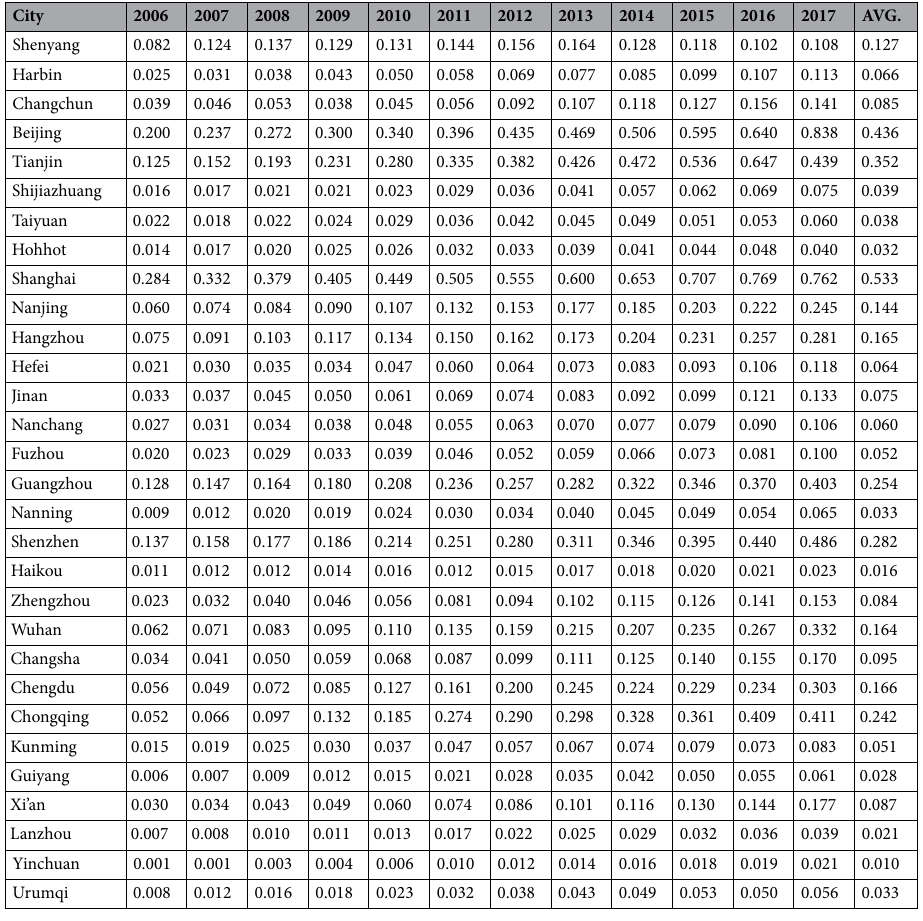
Table 2. Economic subsystem measure